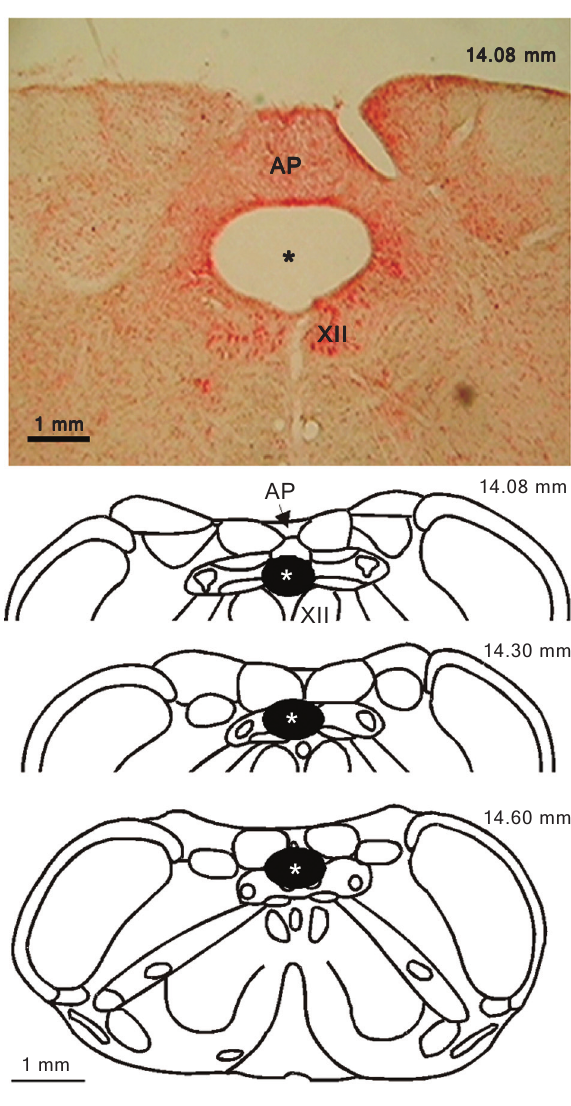
Figure 1. Photomicrograph of a coronal section from the brain stem showing a typical example of a commissural nucleus of the tractus solitarius lesion (asterisk) and diagrams showing the rostral-caudal extension of the lesion from bregma. AP = area postrema; XII = hypoglossal nucleus.